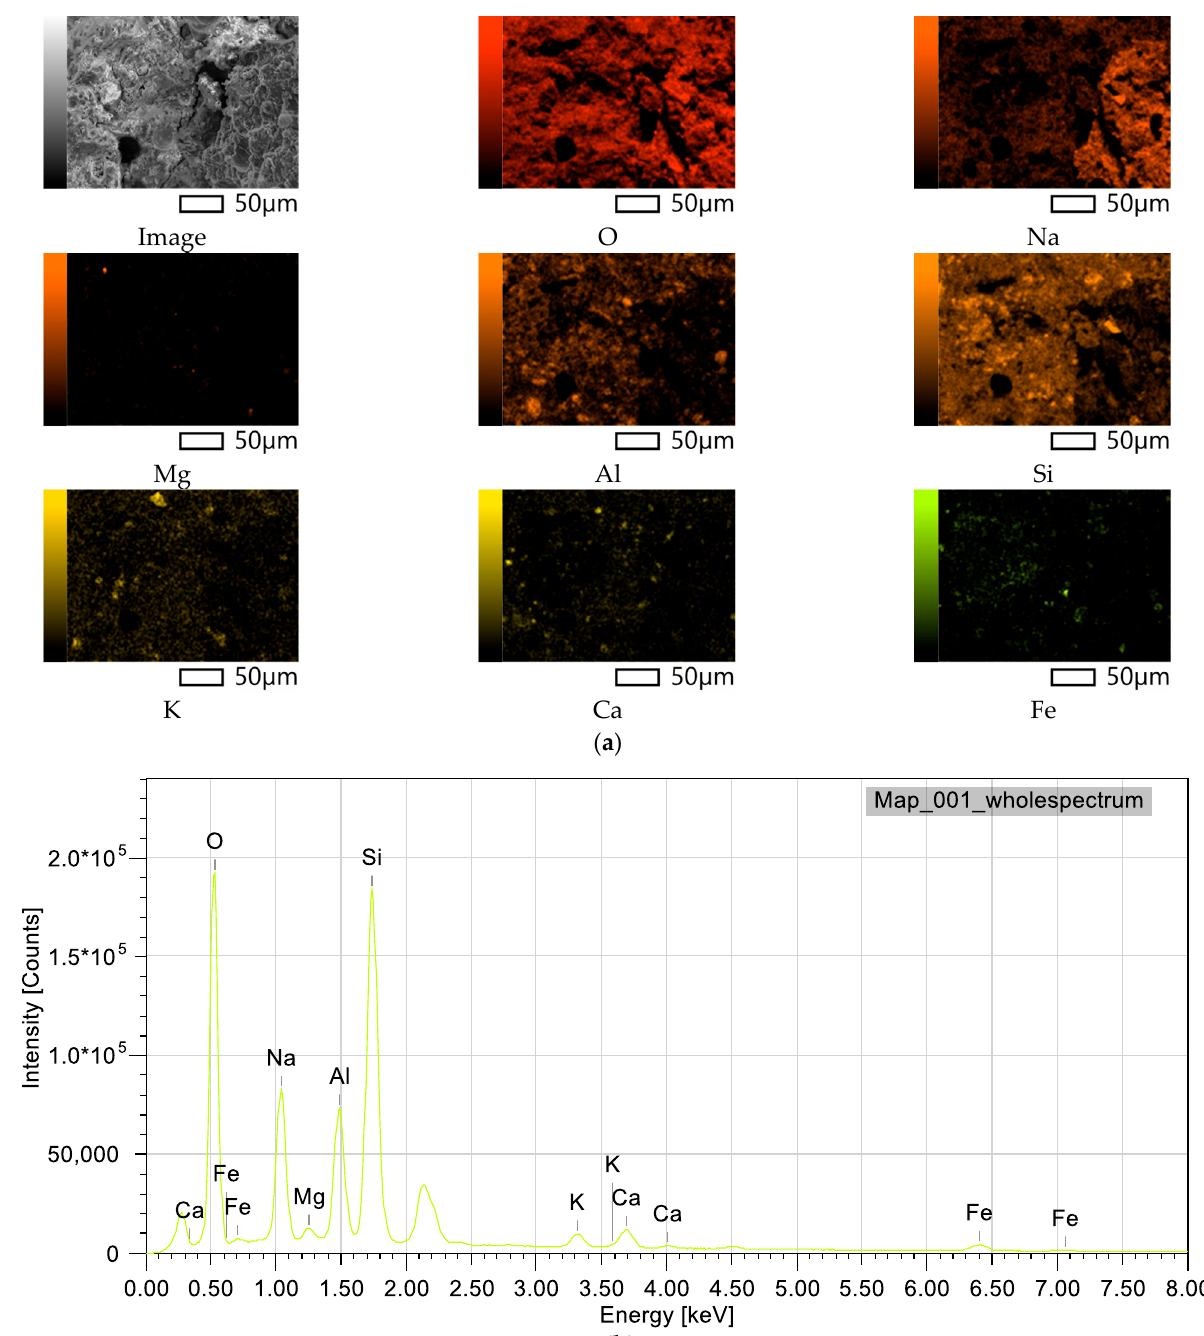
Figure 7. SEM images of sample G2 ( a ) elemental mapping; ( b ) whole spectrum.